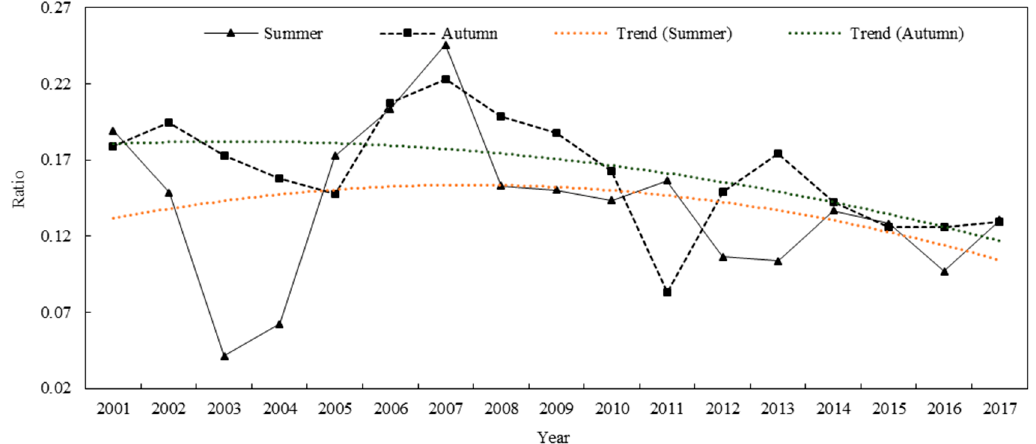
Figure 13. Trends in the ratio of the algal bloom outbreak area to the total water area in two seasons from 2001–2017 (the bloom area represents the high-risk area).